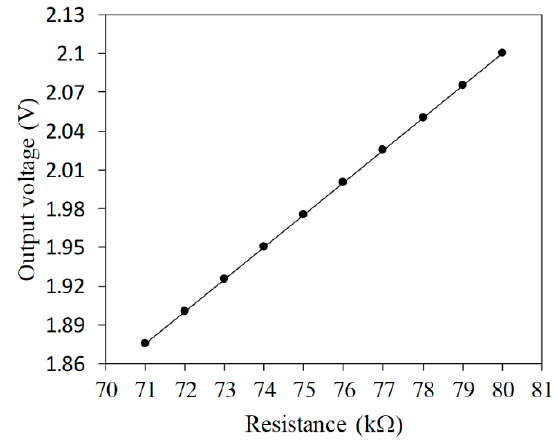
Figure 3. Evaluated output voltage for the AGS.